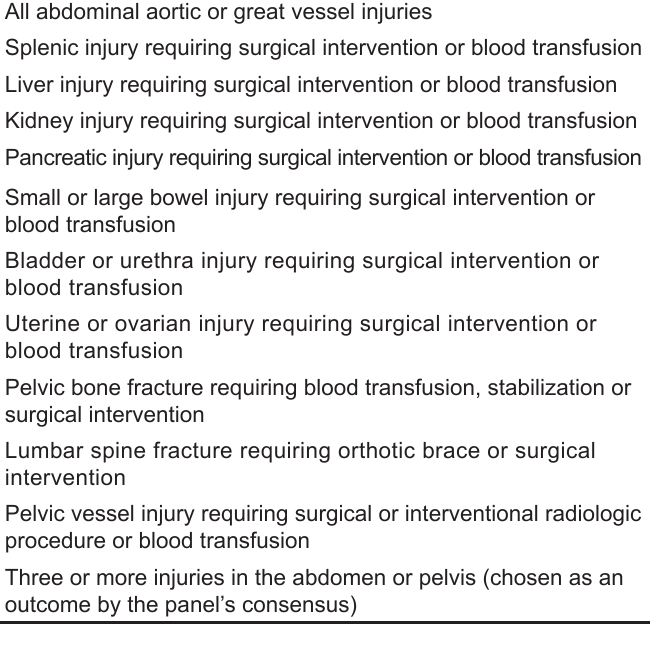
Table 1. Multidisciplinary expert-panel classification of clinical significant injuries.